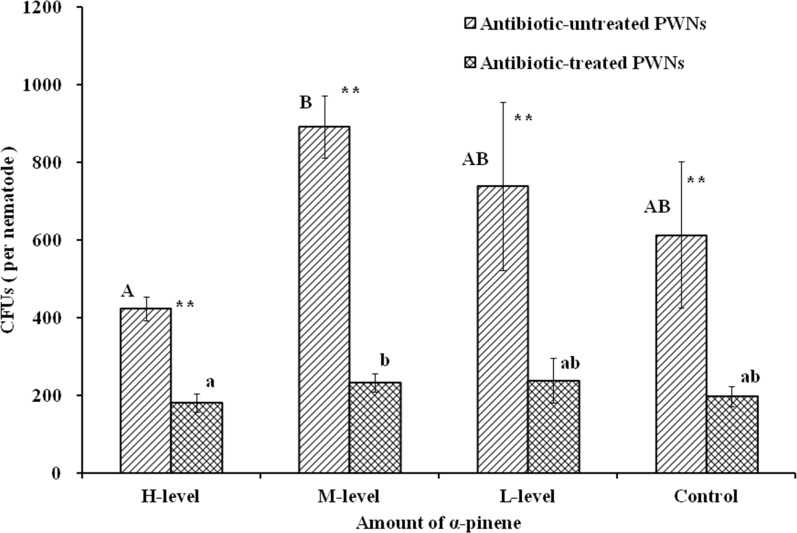
CFUs of bacteria.Different letters indicate significant (p < 0.05) differences in CFUs of corresponding nematode groups, as detected by Tukey's HSD test. Dots represent differences between two nematode groups (*p < 0.05, ** p < 0.01).